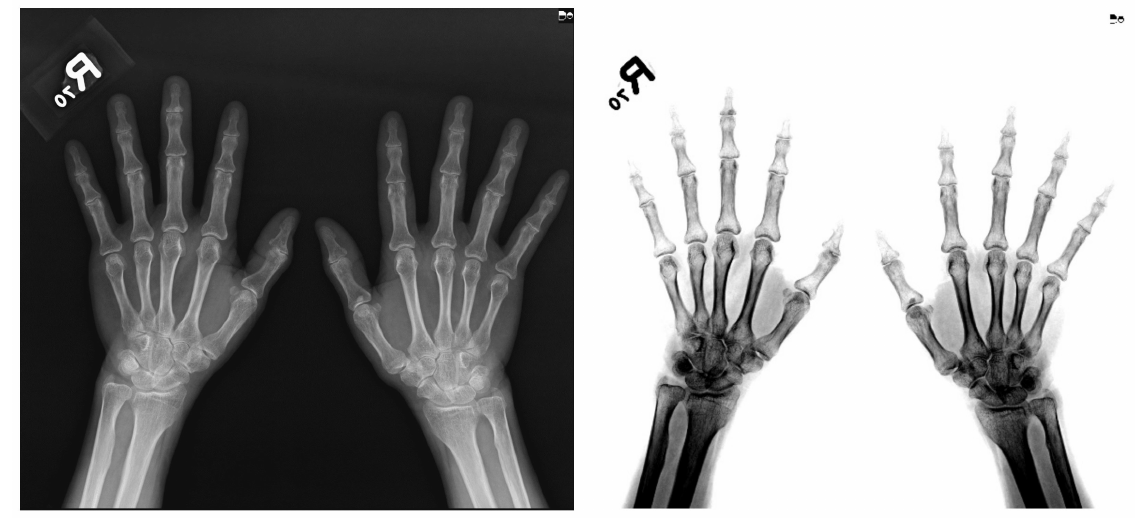
Figure 2. A sample after window level adjustment.